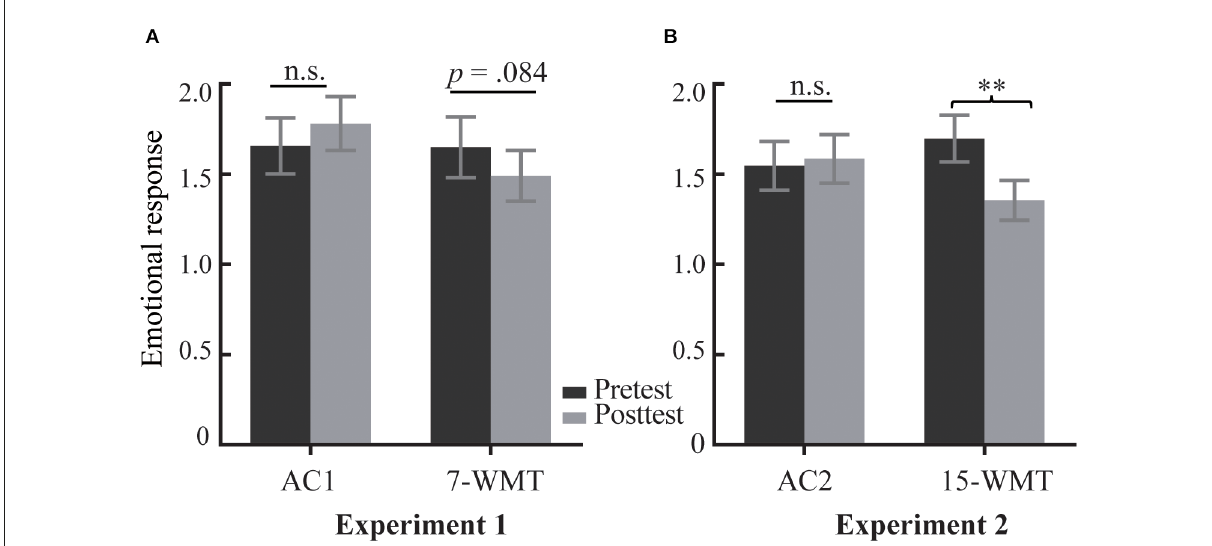
FIGURE3 Transfer effects from WM training to emotional response in Experiment 1 and Experiment 2. Means and standard errors of emotional response (Attend − Neutral) for the 7-day/15-day WM training group (7-WMT/15-WMT) and the active control group (AC1/AC2) at the pretest and posttest in Experiments 2 (A) and 3 (B) . ∗∗ p < 0.01; n.s., non-significant; WM, working